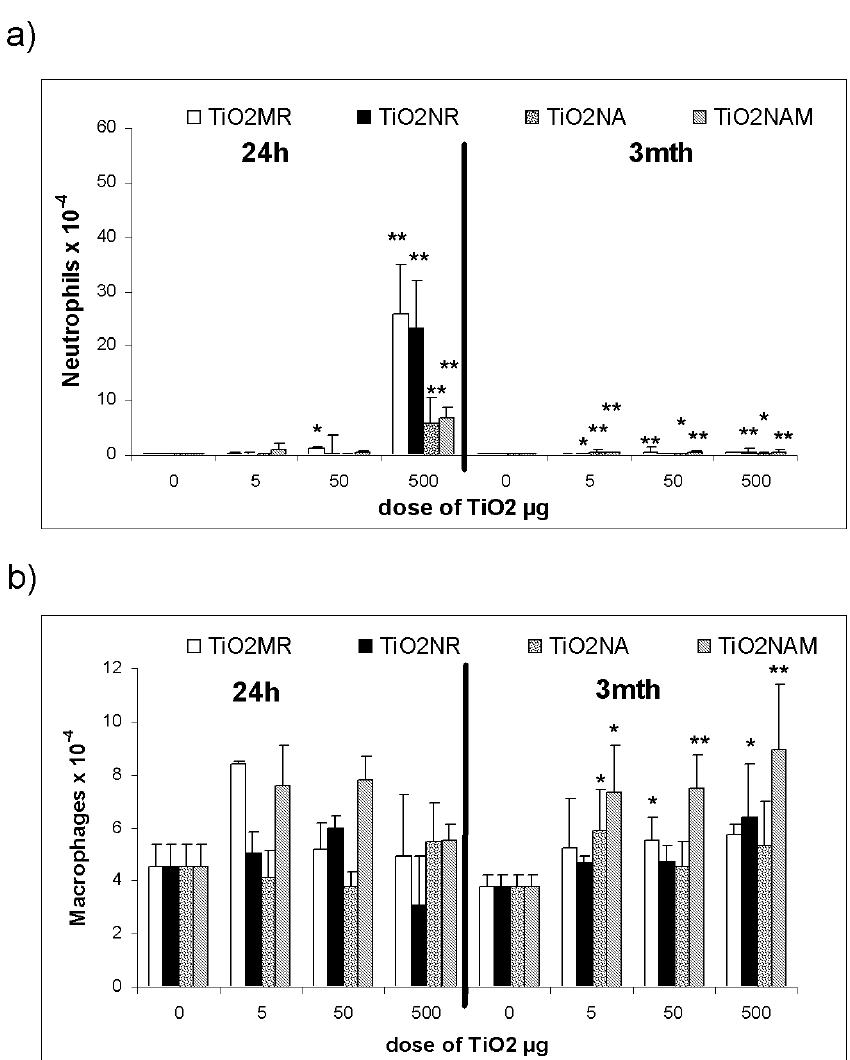
FIGURE 7 . TiO - inflammatory cells in BALF. Collection of BALF was 2 performed 24 h or 3 months after a single i.t. instillation of TiO for micro-size 2 rutile (MR - white), nano-size rutile (NR - black), nano-size anatase (NA - dotted), and nano-size amorphous (NAM - dashed) in BALB/c mice. (a) Neutrophils; (b) macrophages in BALF. Number of cells is shown as the median and 75 th percentile. For explanation of statistical test results (* and **), see Statistics. Each group contained eight